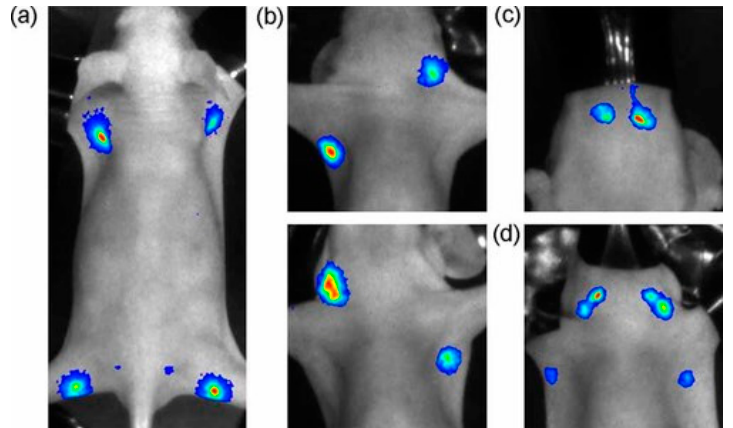
Figure 7. BRET lymphatic images of different lymphatic basins. BRET-QD655 were injected at all four paws ( a ), the ear and forepaw ( b ), the chin ( c ), or five different sites ( d ) both forepaws, both ears and chin). Reprinted with permission from [59]. Copyright 2011 John Wiley and Sons.